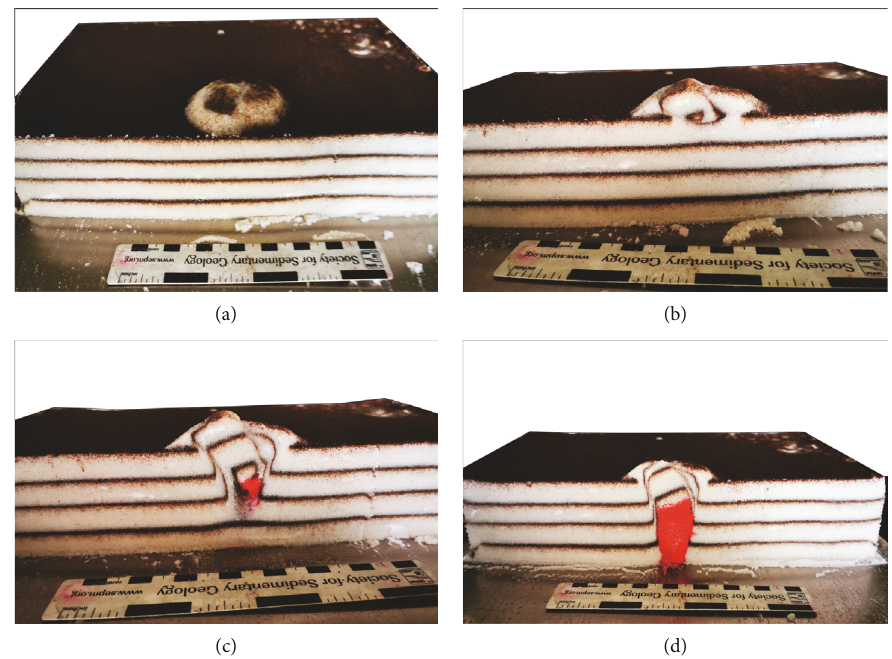
Figure 5: Experiment 1-2 records the formation simulation of mud diapir under overpressure. (a) After fl uid injection, the model surface forms a mound shaped uplift; (b) the side section of the model shows the formation fold deformation inside the mound shaped uplift; (c) the cross section of the model outer edge shows that under the action of fl uid arching, the formation appears to have an upward bending deformation; (d) the cross section of the model center shows the formation fault puncture under the action of diapir, and the formation on both sides appears to have an obvious fold deformation upward